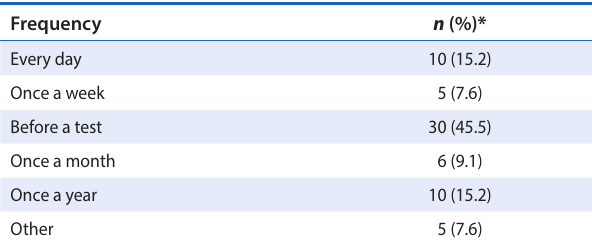
*Only one option could be selected.